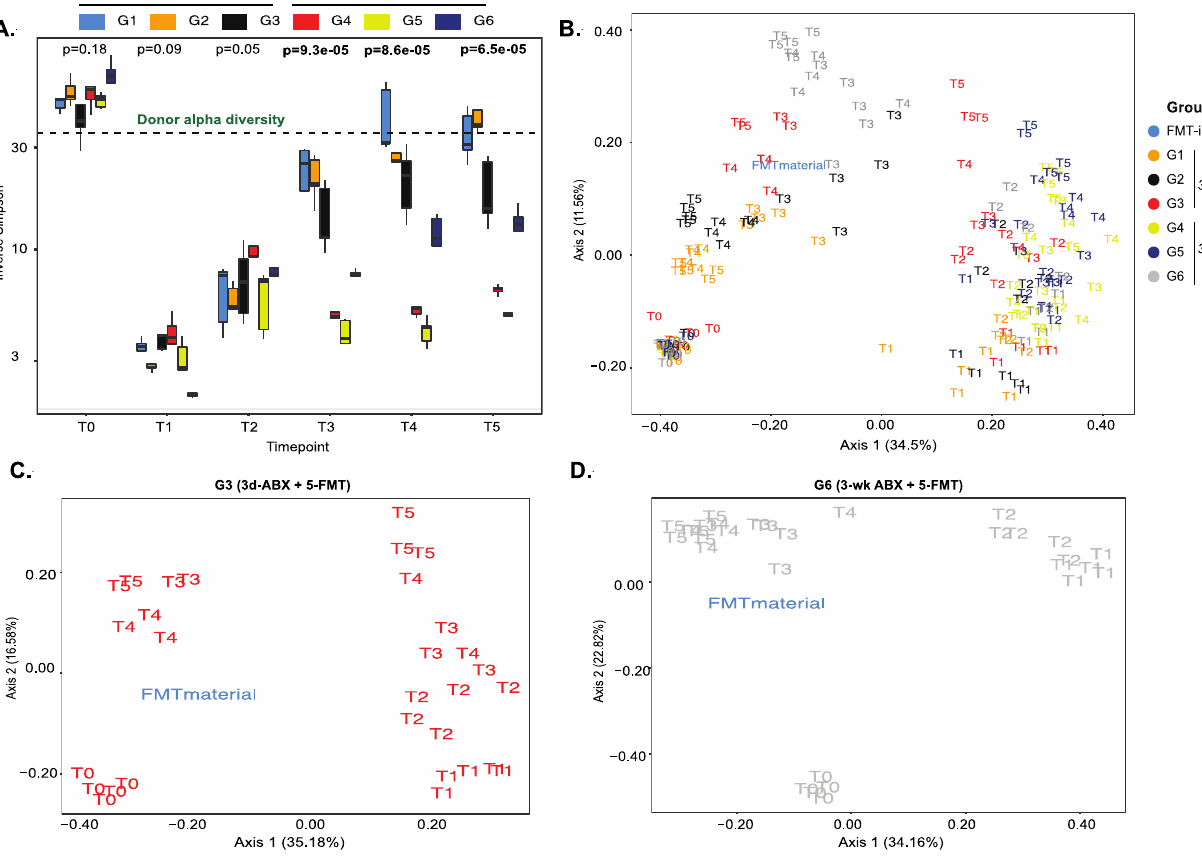
Figure 2. Analysis of diversity. ( A ) Box plots of longitudinal changes in alpha diversity scores over time ( n = 5 mice/group; p -value by Kruskal–Wallis test). PCoA plot of unweighted UniFrac beta-diversity distances in ( B ) all groups, ( C ) G3 mice and ( D ) G6 mice ( n = 5/group; p -value by ANOSIM). Other groups in Figure S4.